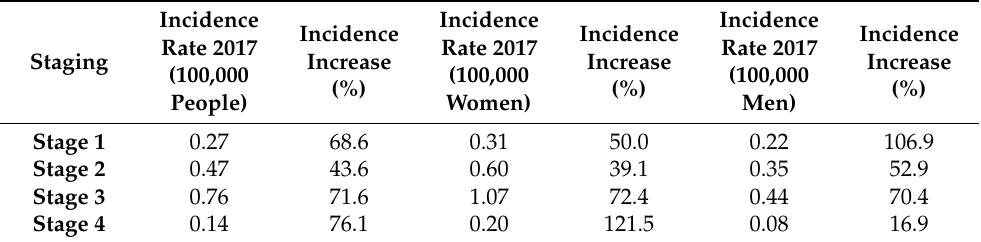
Table 3. Percentage increase in incidence rates in England between 2013 and 2017 by gender and